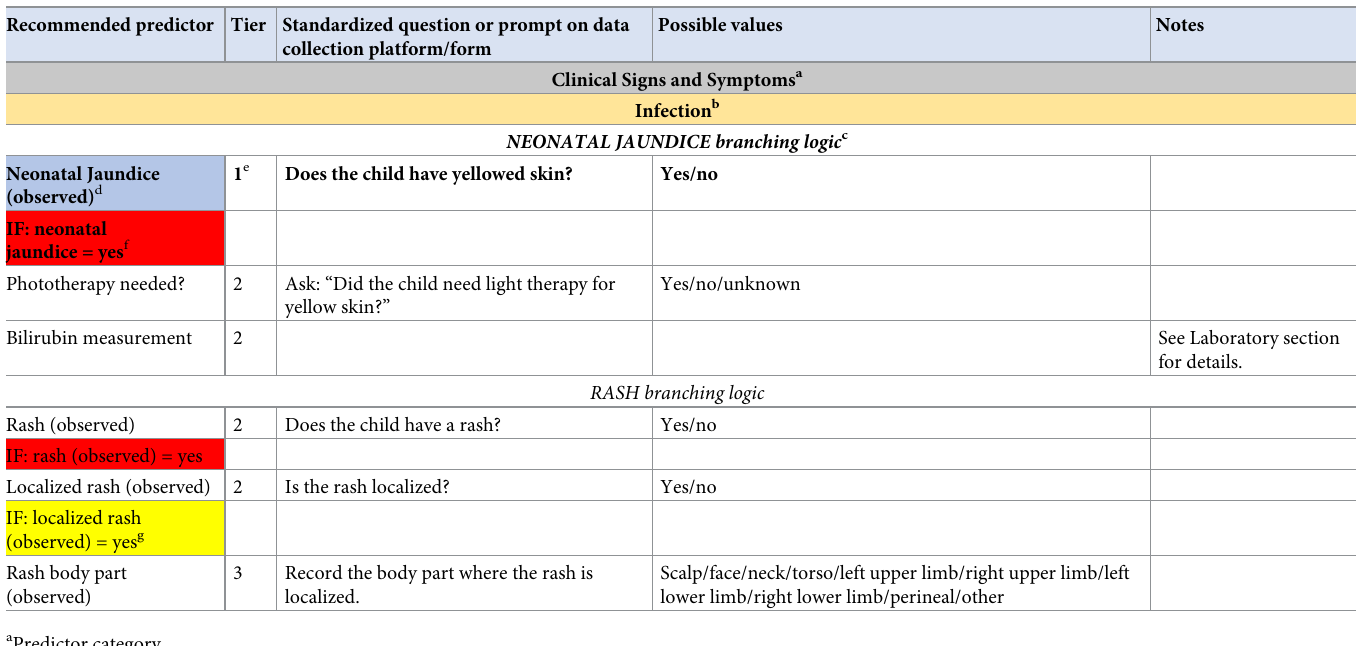
Table 1. Schematic of the common data element guidelines with examples. Recommended predictor Tier Standardized question or prompt on data collection platform/form